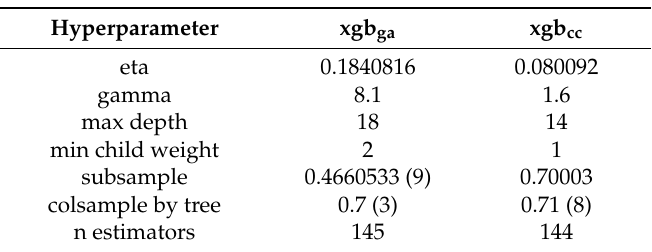
Table 12. Evolved